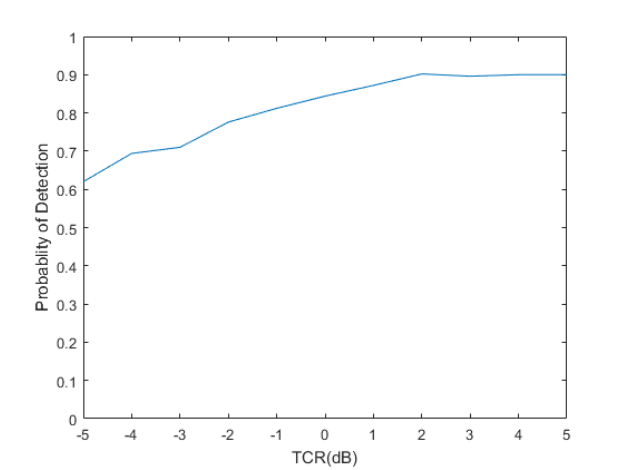
Figure 12. AUC values with respect to target to clutter ratio (TCR) for the test data set.